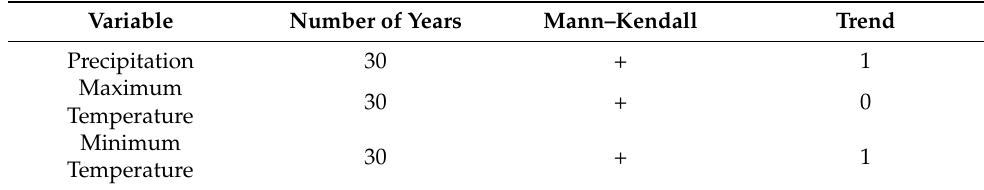
Table 2. Mann–Kendall Trend Test